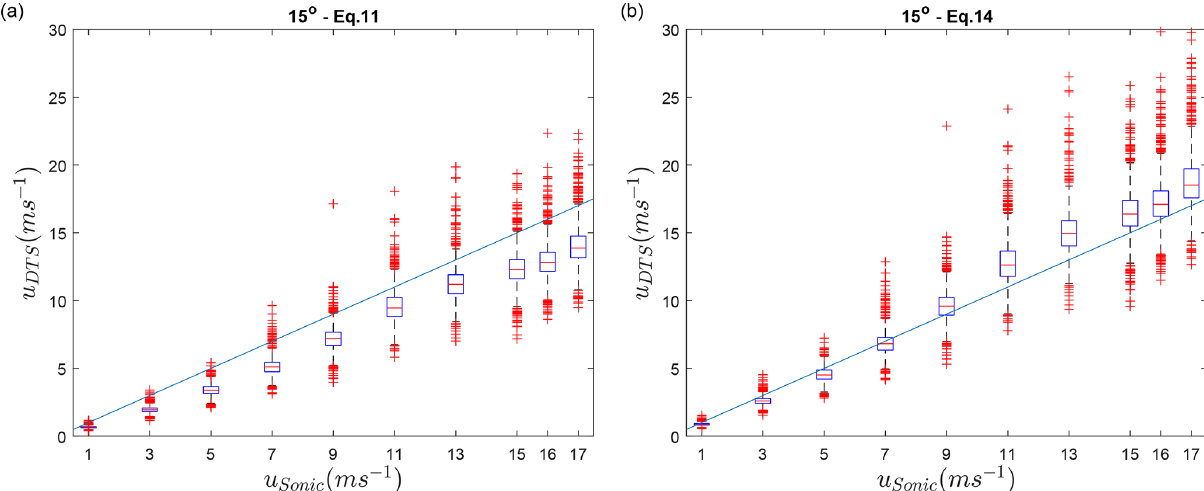
Figure 3. Directional sensitivity shown in box plots for the 15 ◦ angle, original Eq. (11) (a) and proposed Eq. (14) (b) . The line represents the 1 : 1 line.